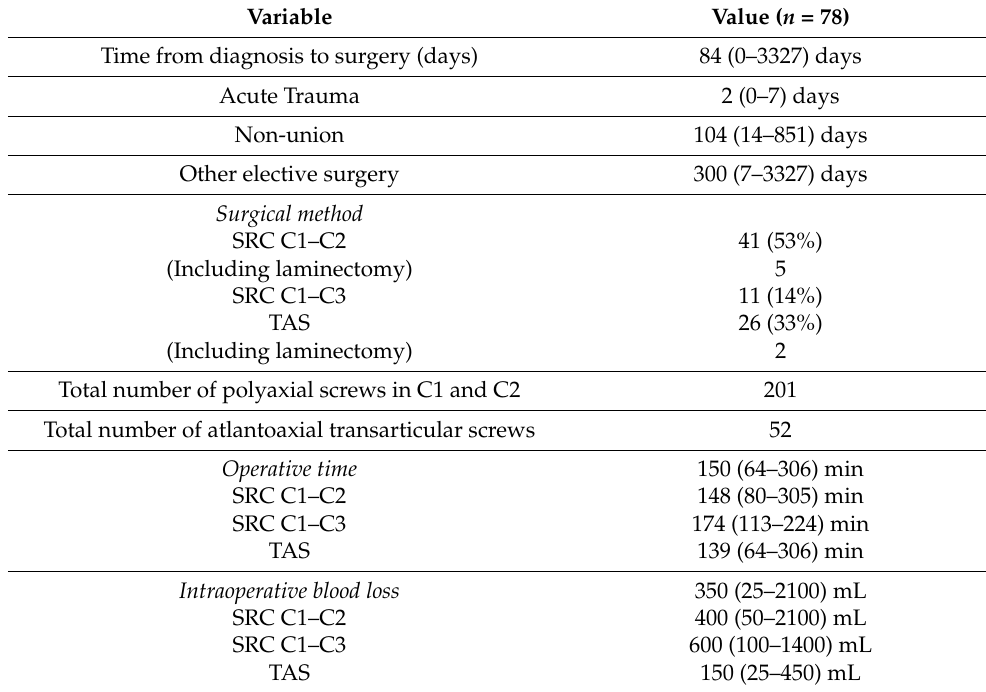
Table 2. Treatment